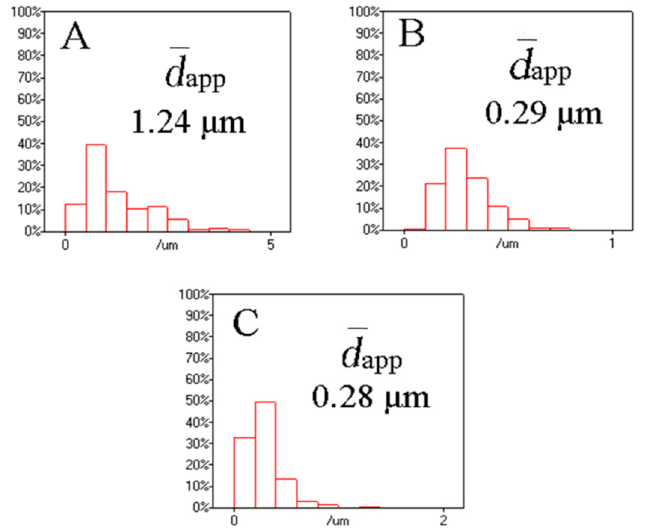
Figure 12. Statistical results for apparent particle sizes of PETG/PGA/ADR (65/35/x; x = 0.3 (A) , 0.6 (B) , and 0.9 (C) ) sam-